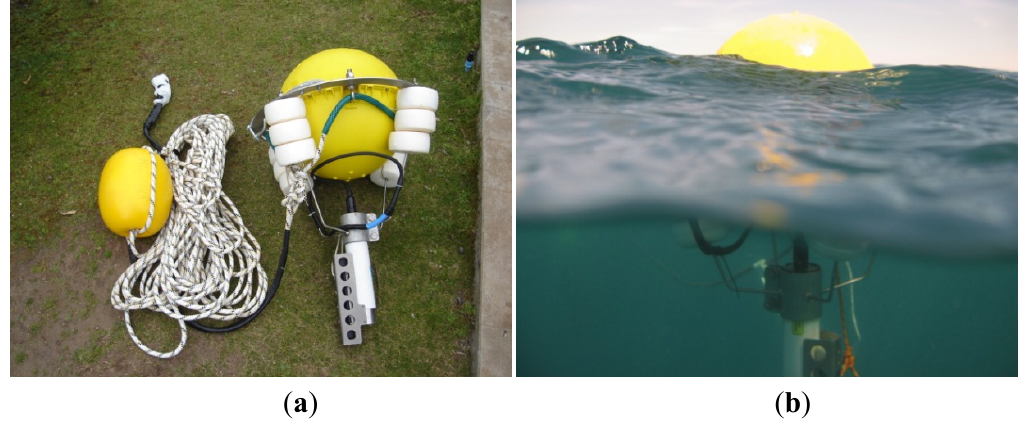
Figure 8. Surface drifter for near surface salinity measurements with real-time or near real-time transmission capabilities designed and deployed for SMOS validation [65].